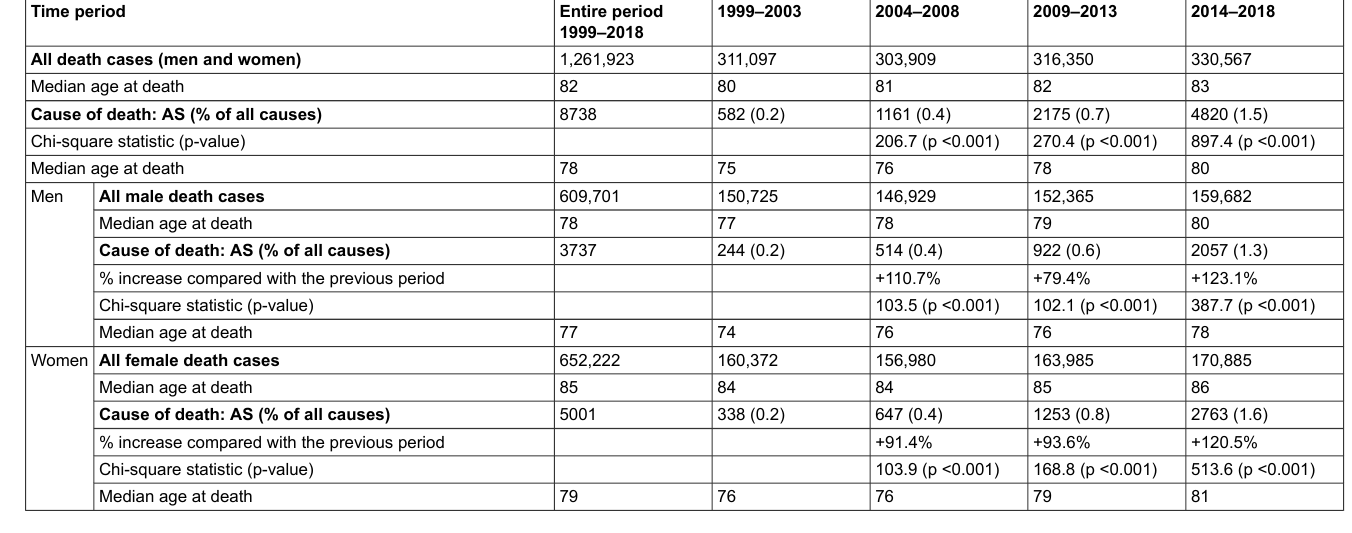
Table 2: Death cases in Switzerland (1999–2018) with particular consideration of assisted suicide (AS) as cause of death. Time period